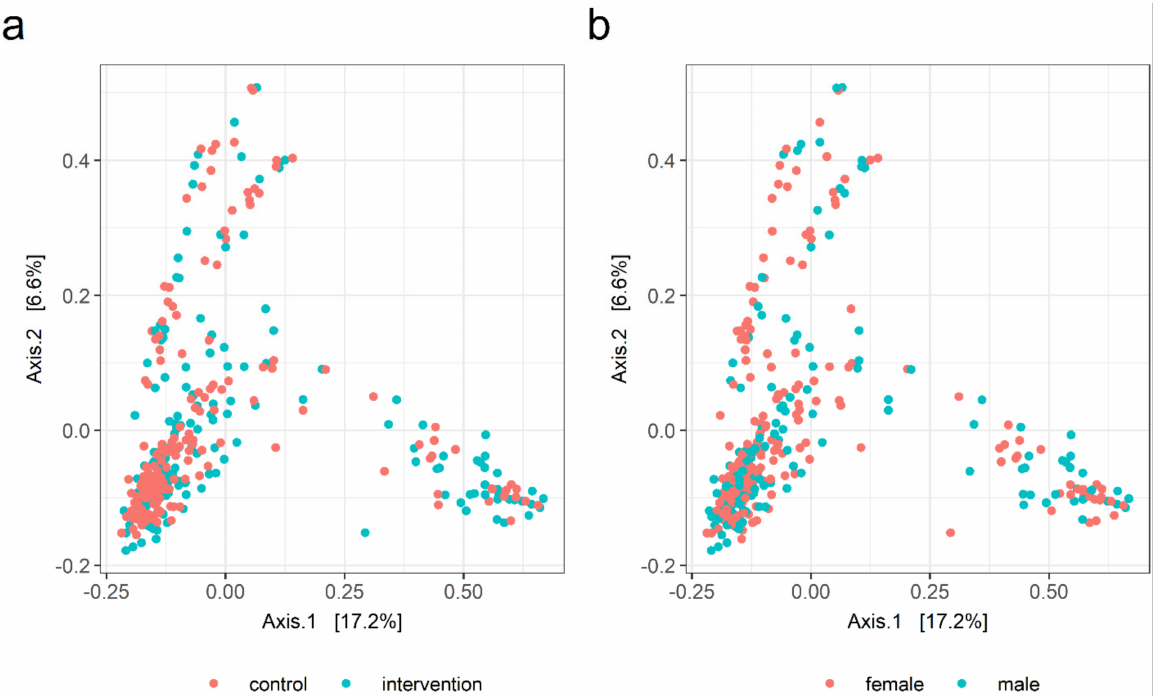
Figure 2. PCoA ordination plots for gut microbiota beta diversity: ( a ) in the dietary counselling intervention and control groups (PERMANOVA R 2 = 0.004, p = 0.09) and ( b ) for females and males (R 2 = 0.005, p =